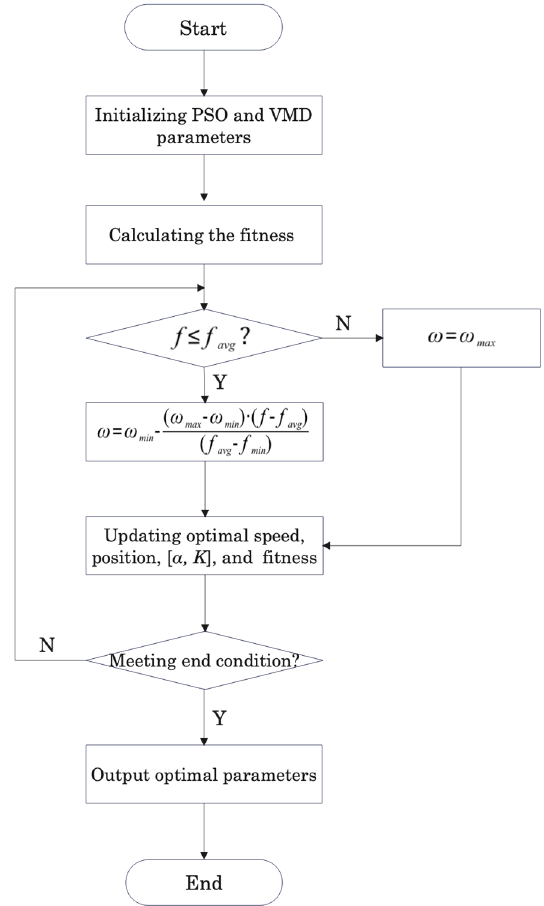
Figure 1. Flowchart of the adaptive-weight particle swarm optimization (PSO) - variational modal decomposition (VMD).